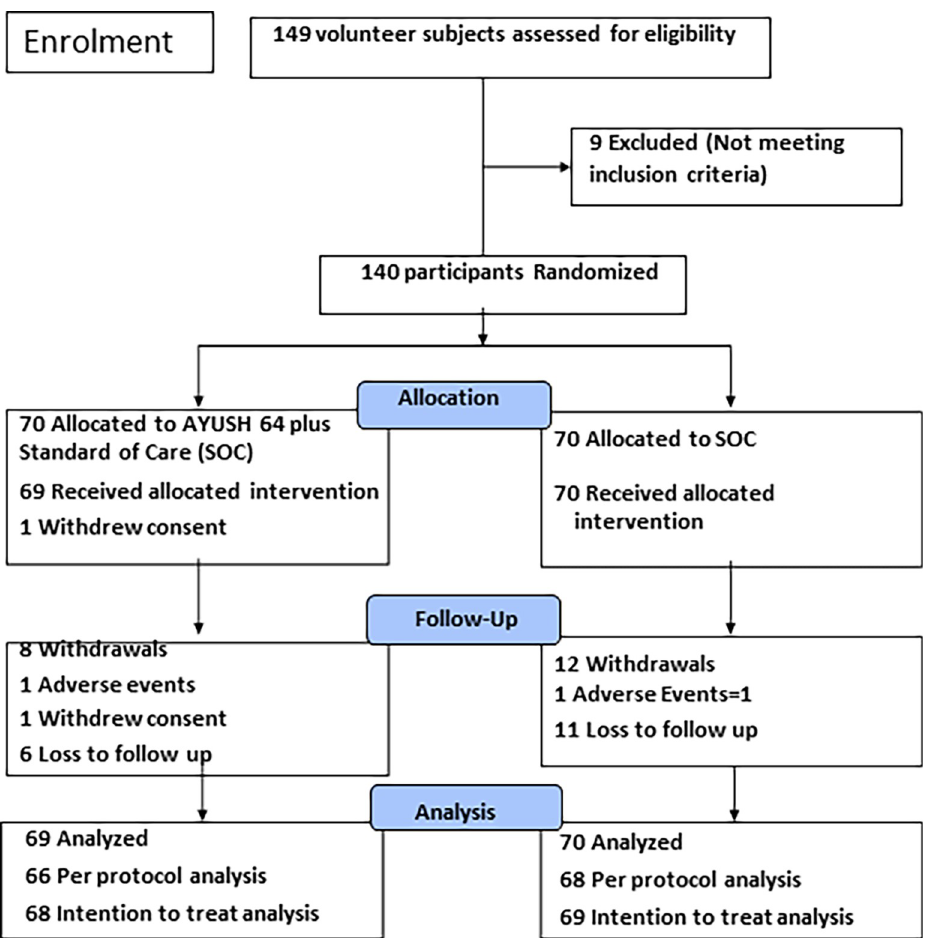
Fig 2. Patient disposition and withdrawals: A randomized controlled study to evaluate the co-administration of AYUSH-64 with Standard of Care (SOC) in–mild-moderate symptomatic COVID-19 (CONSORT flow diagram).